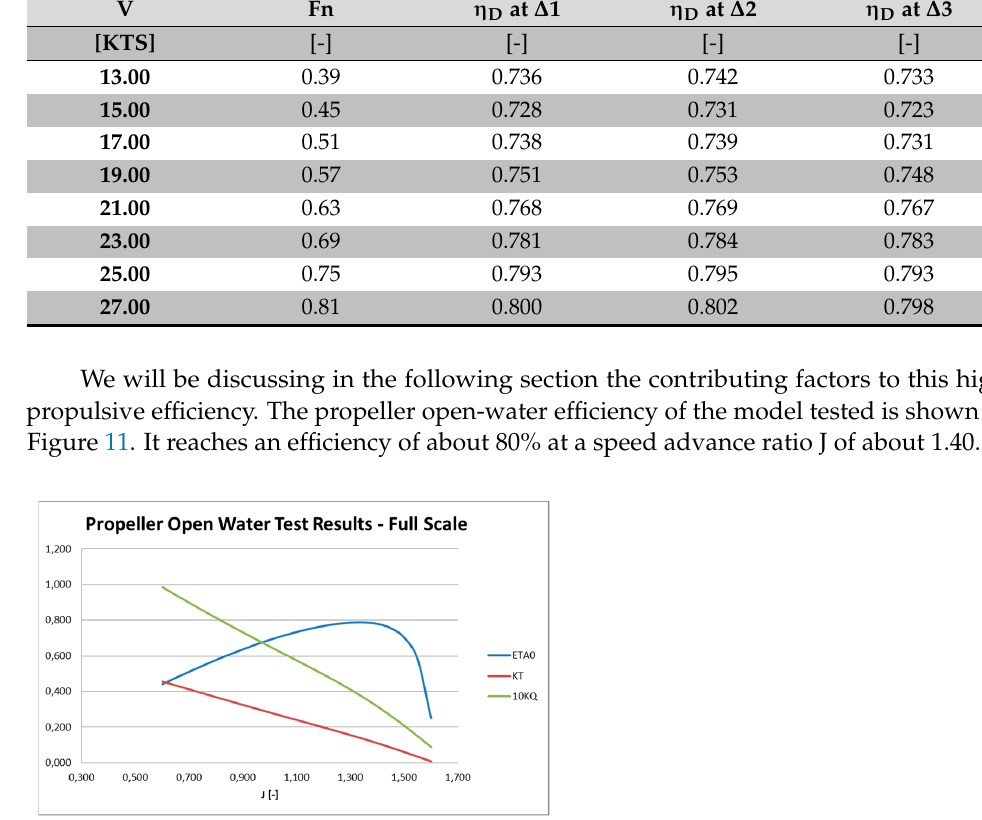
Figure 11. Propeller open-water efficiency test results .